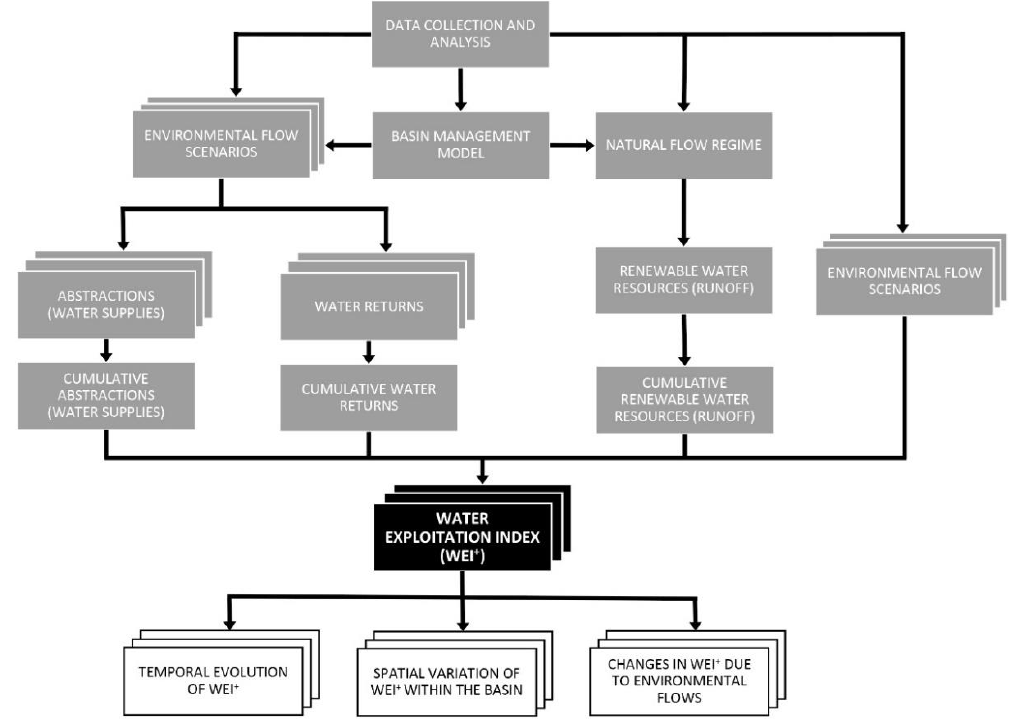
Figure 2. Flowchart of the methodology of this work.